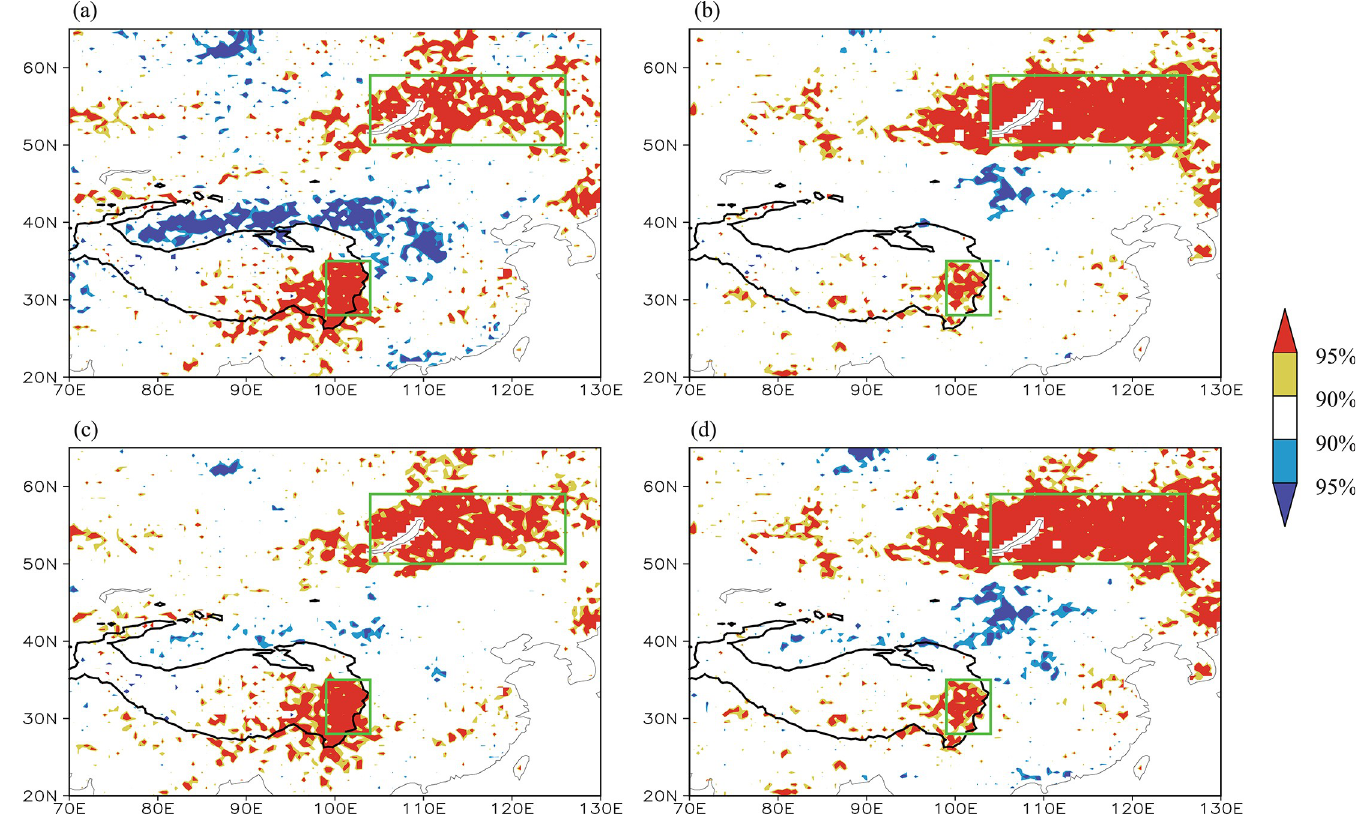
Fig 2. (a) Distribution of the correlation coefficients between the summer NDVI index on the Tibetan Plateau and the simultaneous NDVI field during the time period 1982–2014. (b) Distribution of the correlation coefficients between the summer NDVI index in the Lake Baikal region and the simultaneous NDVI field. (c) Distribution of the correlation coefficients between the summer NDVI index on the Tibetan Plateau and the simultaneous NDVI field during the time period 1982–2014 after removing the linear trends. (d) Distribution of the correlation coefficients between the summer NDVI index in the Lake Baikal region and the simultaneous NDVI field during the time period 1982–2014 after removing the linear trends. The solid contour denotes areas higher than 3000 m altitude. The yellow (red) shading denotes a positive correlation significant at the 90% (95%) confidence level and the blue (purple) shading denotes a negative correlation significant at the 90% (95%) confidence level. The two green boxes from top to bottom indicate the Lake Baikal (50–59˚ N, 104–126˚ E) and eastern Tibetan Plateau regions,